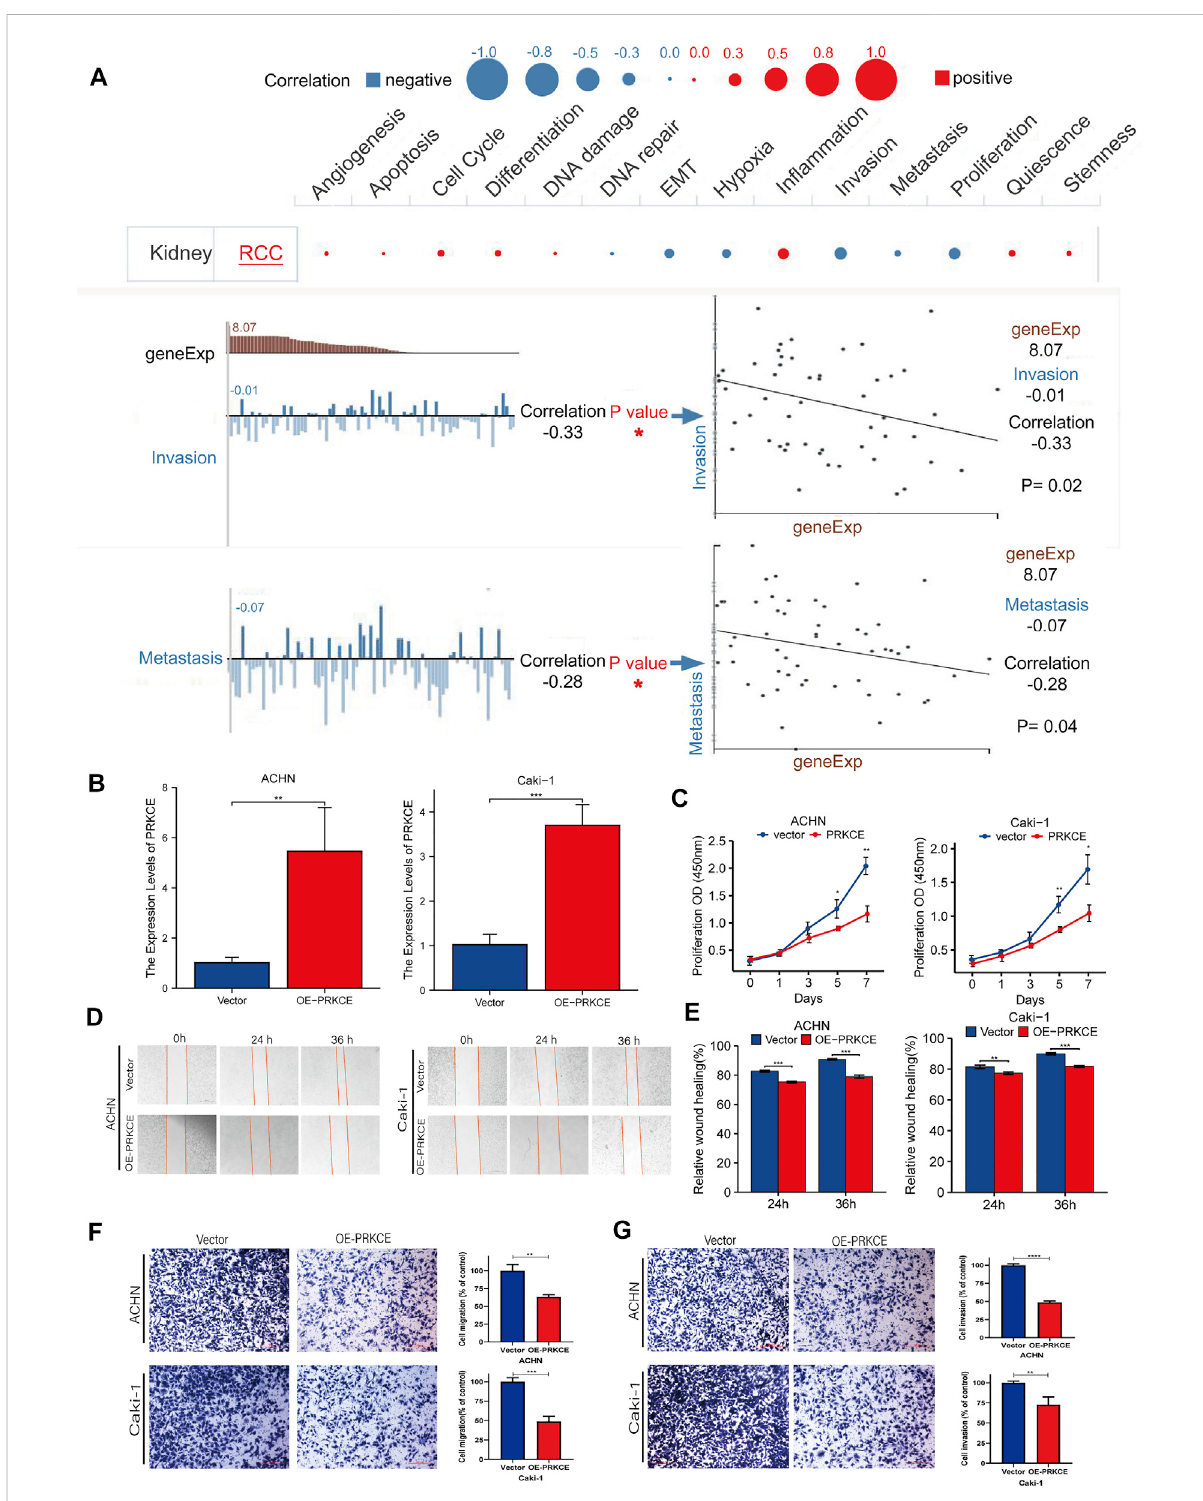
FIGURE 3 PRKCEoverexpressionsuppressesproliferation,migration,andinvasionofkidneyrenalclearcellcarcinomacells invitro . (A) Single-cellanalysis showed the functional state of PRKCE in KIRC. CancerSEA analysis demonstrated that PRKCE negatively correlated with regulating proliferation, migration, and invasion. (B) The mRNA level of PRKCE in kidney renal clear cell carcinoma cells was detected by qRT-PCR. (C) The CCK8 assays showed that PRKCE overexpression attenuated the proliferation of kidney renal clear cell carcinoma cells. (D,E) Wound healing assays demonstrated that PRKCE overexpression inhibited the migration ability of kidney renal clear cell carcinoma cells. (F, G ) The migration and invasion abilities of ACHN and Caki-1 were weakened after overexpressing